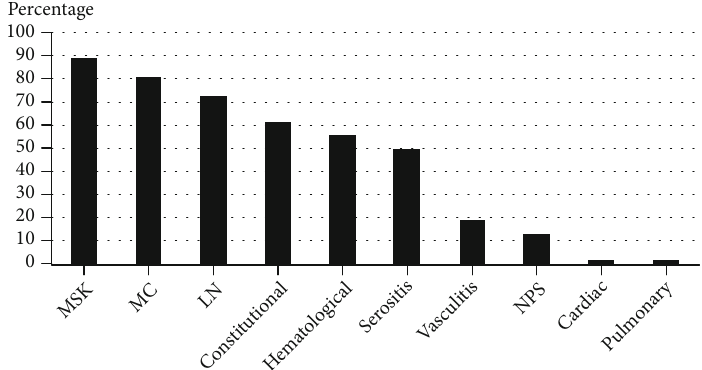
Figure 1: The frequency of the di ff erent disease phenotypes in the lupus cohort. MSK: musculoskeletal; MC: mucocutaneous; LN: lupus nephritis; NPS: neuropsychiatric.